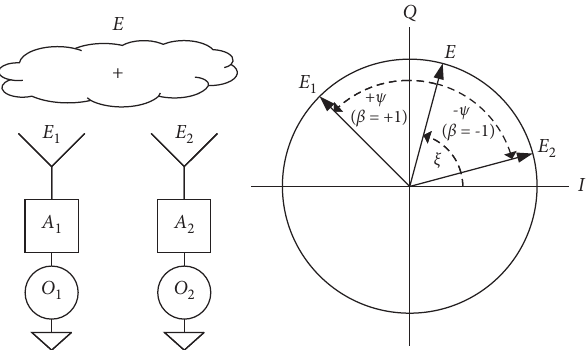
Figure 1: Basic outspacing concept, where amplitude modulation is achieved by vectorial addition of two phase ( ψ ) modulated signals in space. E is the complex amplitude of the electric field represented in the frequency